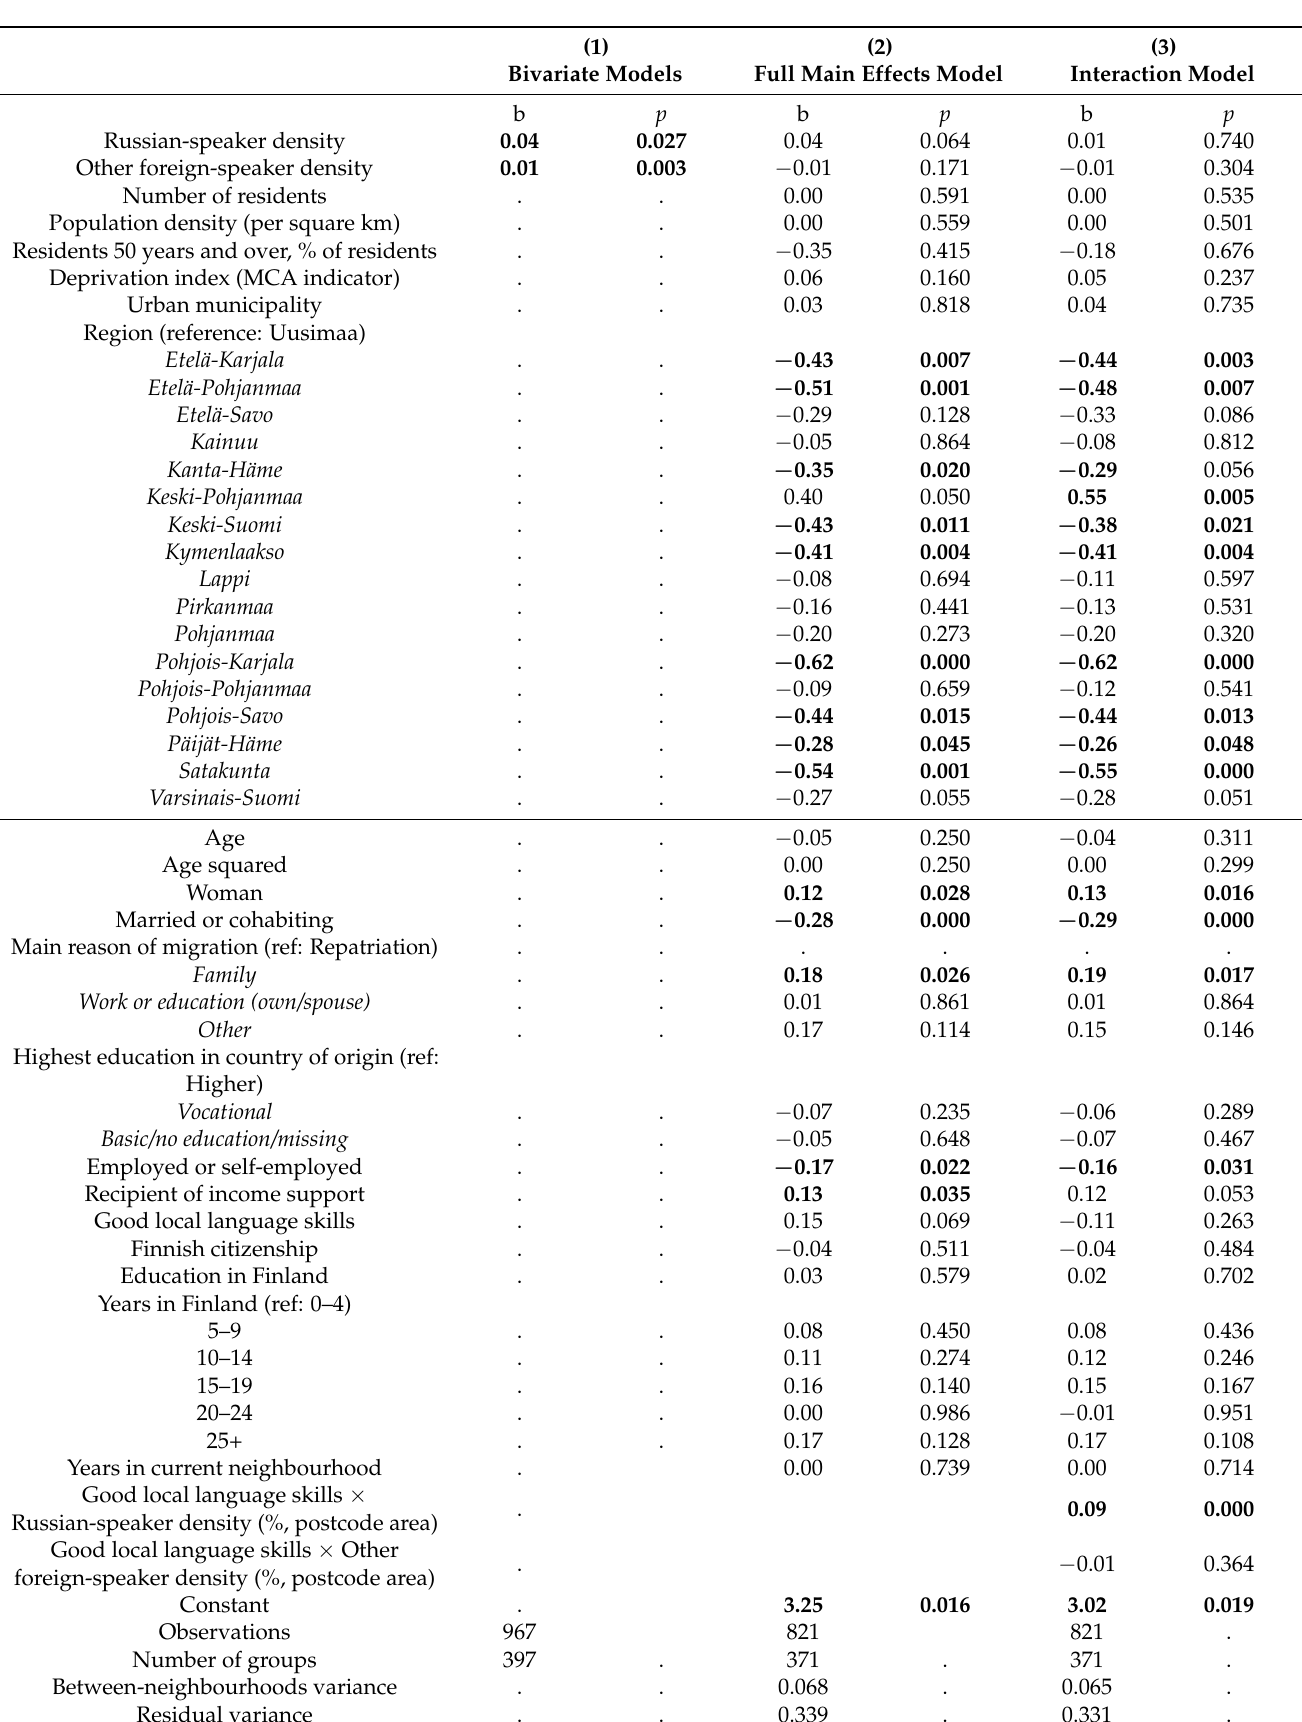
Table 3. Linear mixed model on